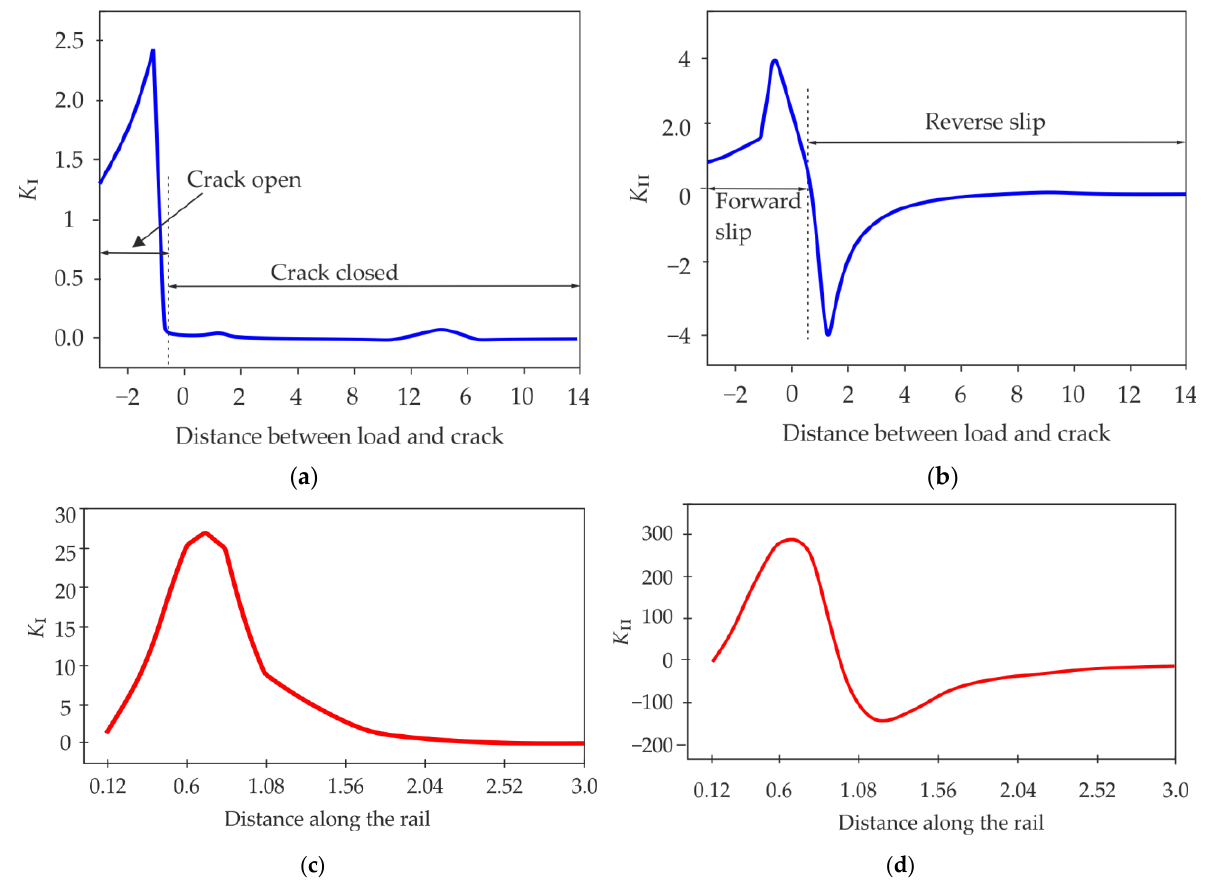
Figure 17. Stress intensity factors for Mode I and Mode II from the literature and Adapcrack3D: ( a ) K I along the crack front in which the load starts before the crack and rolls over it (according to [44]); ( b ) K II along the crack front in which the load starts before the crack and rolls over it (according to [44]); ( c ) K I calculated by Adpcrack3D along the crack front when the wheel rolls over the rail; ( d ) K II calculated by Adpcrack3D along the crack front when the wheel rolls over the rail.